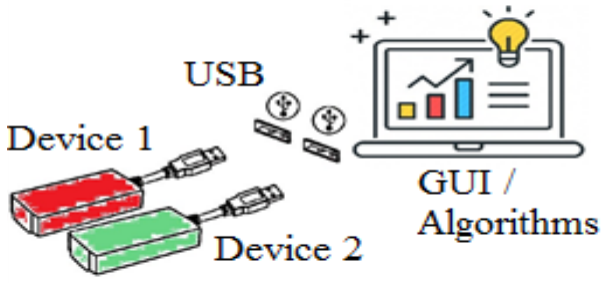
Figure 2. Graphical depiction of the system adoption. After data collection for a specific task, the device(s) are plugged-into a computer via USB, where a GUI will use back-end algorithms to process the data gathered in the device(s) and visualize the results to the